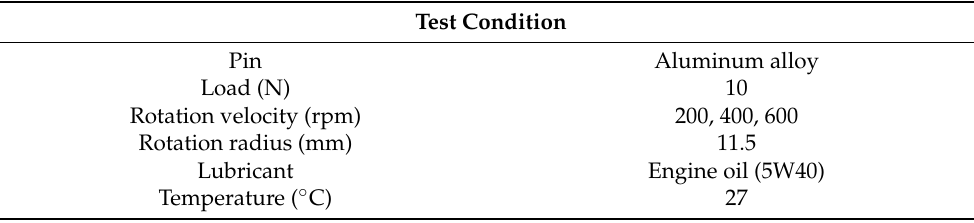
Table 2. Friction test